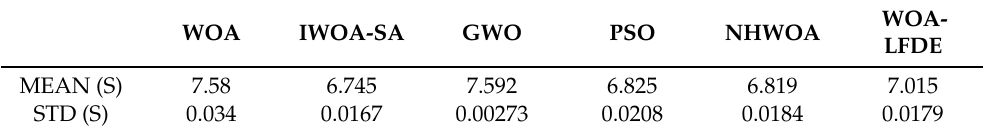
Table 6. Comparison of experimental results of trajectory planning. WOA IWOA-SA GWO PSO